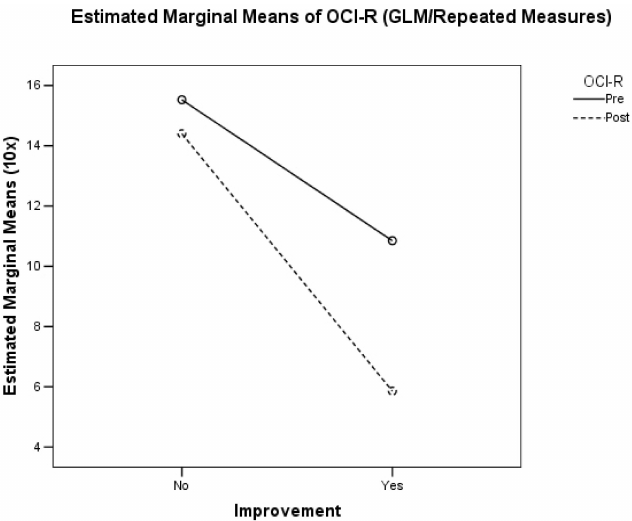
Figure 3. GLM/Repeated Measures Model results ( p < 0.0001). The Estimated Marginal Means were magnified 10 times to improve the readability of the